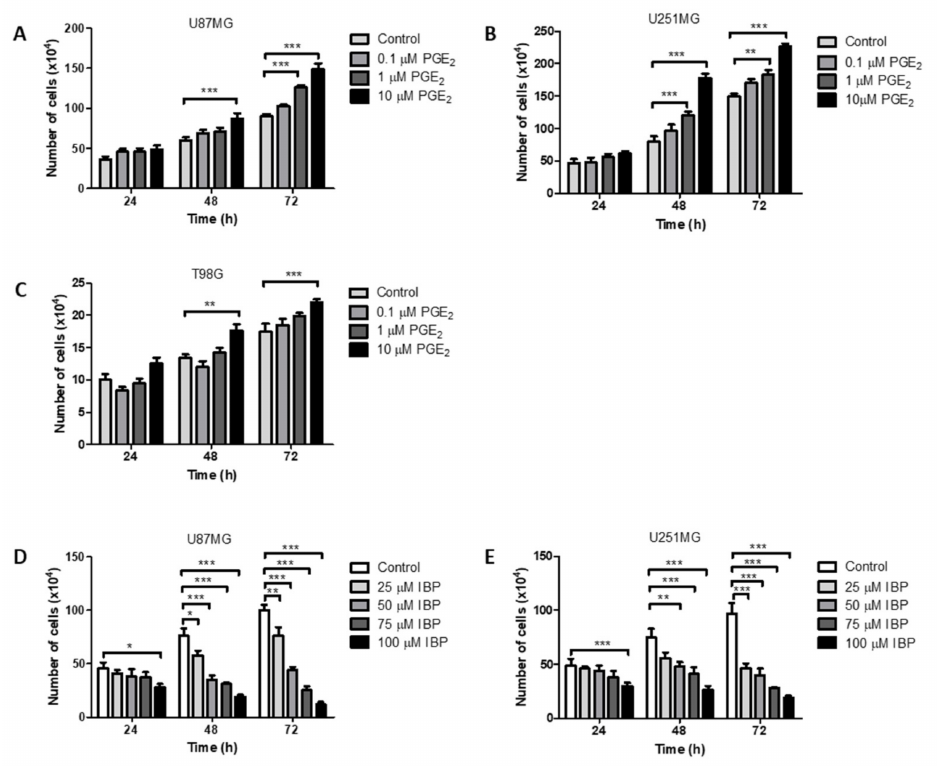
Figure 2. Opposing effects of PGE 2 and COX1/2 inhibitor, IBP, on GBM cell counts. Graphs show the results after 24, 48 or 72 h of treatment with PGE 2 or IBP. ( A ) PGE 2 in U87MG cells; ( B ) PGE 2 in U251MG cells; ( C ) PGE 2 in T98G cells; ( D ) IBP in U87MG cells; ( E ) IBP in U251MG cells. Data are presented as mean + SEM, n = 3–4. A two-way ANOVA with a Bonferroni post-test was performed. Differences were considered significant at p < 0.05. * = p < 0.05; ** = p < 0.01; *** = p <